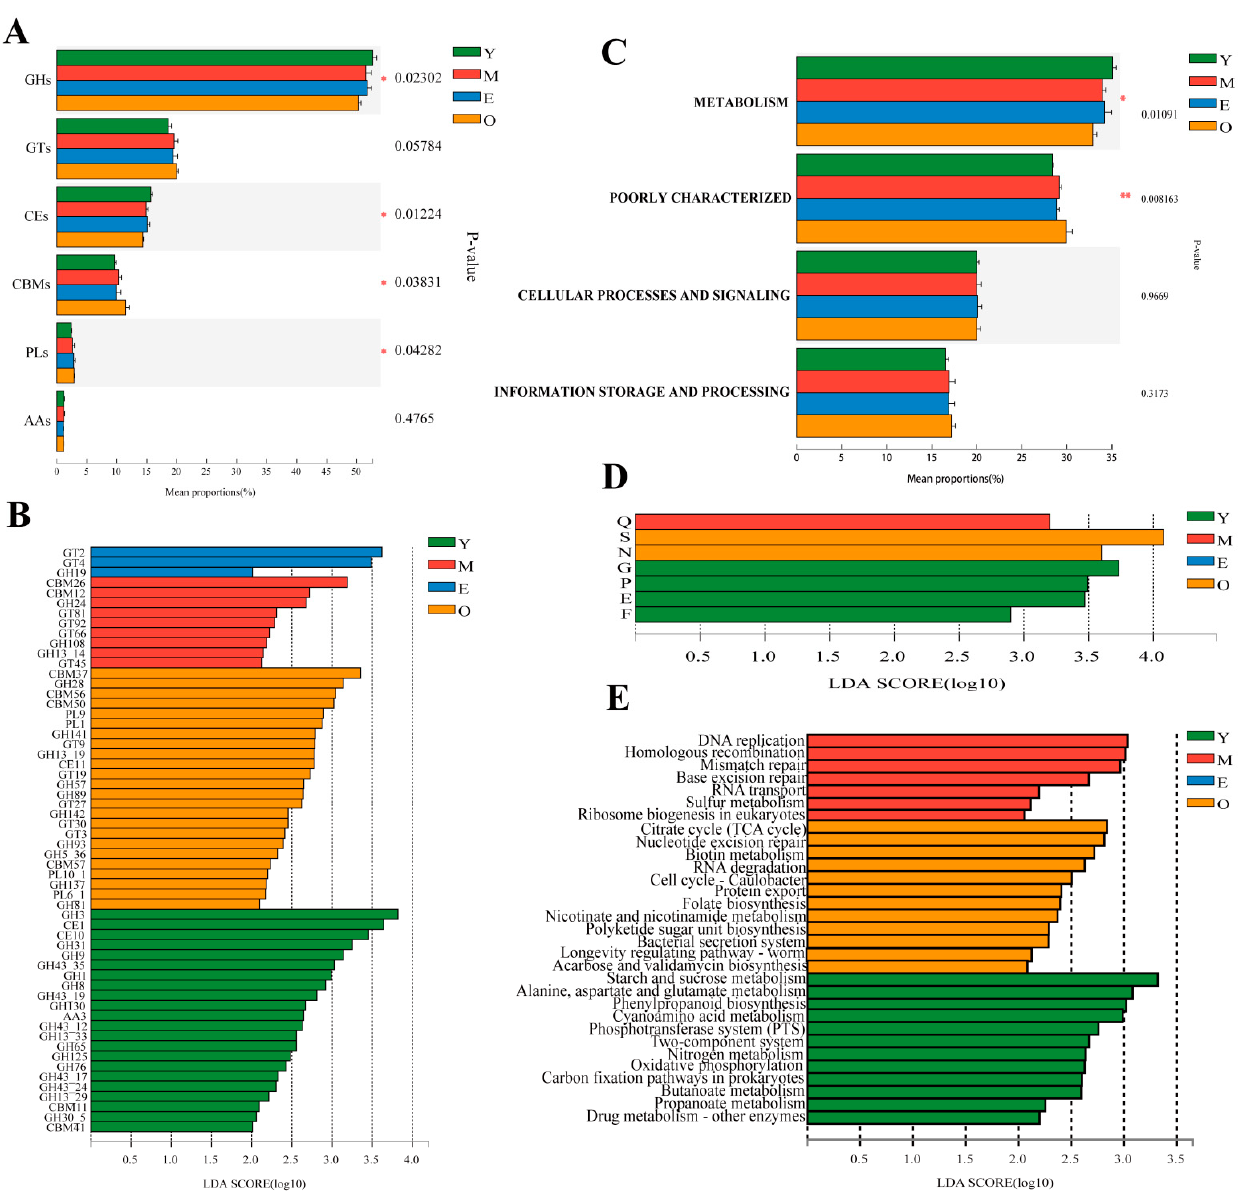
Figure 3. Functional difference of ruminal microbiome of dairy buffaloes. Comparison of predicated CAZyme genes of dairy buffalo rumen microbiota at class ( A ) and family ( B ) levels. Difference analysis of predicted COG genes of dairy buffalo rumen microbiota at category ( C ) and function ( D ) levels. ( E ) Histogram of the LDA scores computed for differentially abundant predicted genes of dairy buffalo rumen microbiota at the KEGG pathway level 3 classification. Significant differences were confirmed by linear discriminant analysis effect size (LEfSe) analysis with the cutoff of LDA > 2 and p < 0.05. GH: glycoside hydrolases; GT: glycosyltransferase; CE: carbohydrate esterases; CBM: carbohydrate-binding modules; PL: polysaccharide lyases; AA: auxiliary activities; *, p < 0.05; **, p < 0.01.